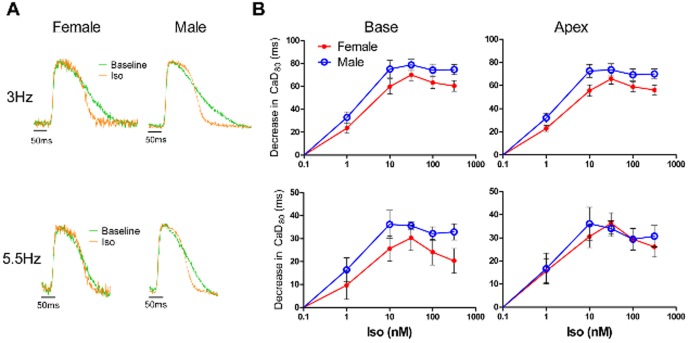
No significant sex differences in Iso-induced decrease of CaD80.A) Representative CaTs at baseline (green traces) and during treatment with Iso (316.2 nM, orange traces) normalized and superimposed to demonstrate the Iso-induced shortening of CaD80 at both 3 Hz (top) and 5.5 Hz (bottom) pacing. B) Summary data for the decrease in CaD80 (versus baseline values) as a function of the dose of Iso (1, 10, 31.6, 100, 316.2 nM) in the LV base (left) and apex (right) with pacing at 3 (top) and 5.5 Hz (bottom) for female (n = 5) and male (n = 5) hearts. Female versus male, p = NS for all comparisons.